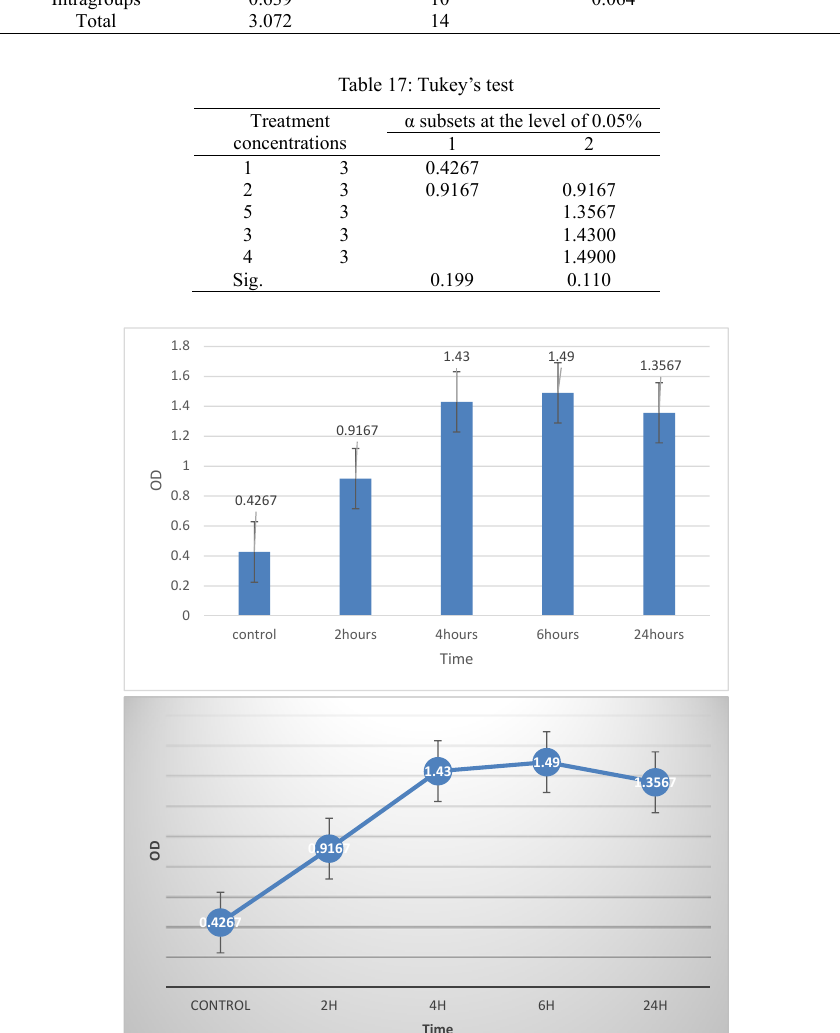
Diagrams3: Means of ODs obtained at different concentrations of nisin-conjugated CuO NPs in the Tukey’s